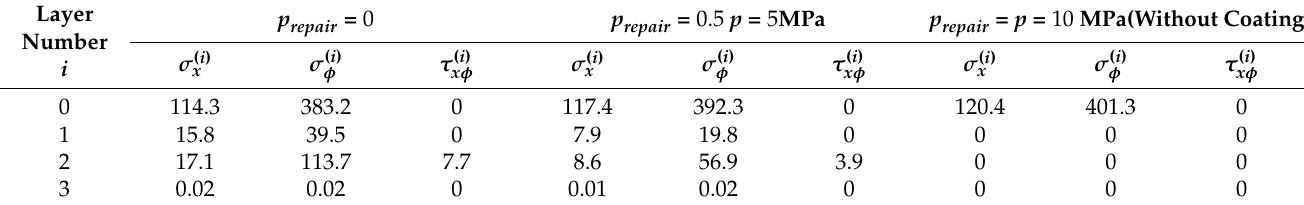
Table 2. Stresses (MPa) in the pipe and in the composite coating ( p = 10 MPa and R = 610